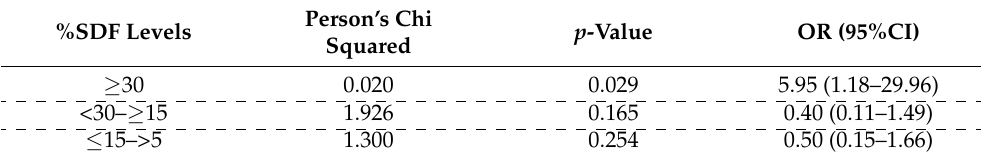
Figure 5. The sperm DNA fragmentation analysis on semen samples within the Test (blue histogram) and Control (orange histogram) groups. The significant difference was calculated through C \ the chi 2 test ( p -value 0.049). p -value < 0.05, *. Table 2. Risk of sperm DNA fragmentation on Test semen samples vs. Control semen samples.